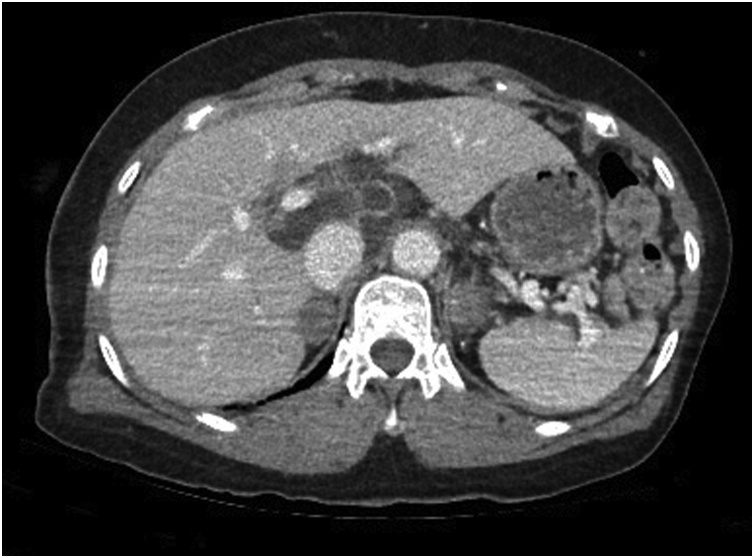
Axial view on an abdominal computed tomography scan of this patient, showing fluid collection and a cystic lesion around the caudate lobe of the liver.